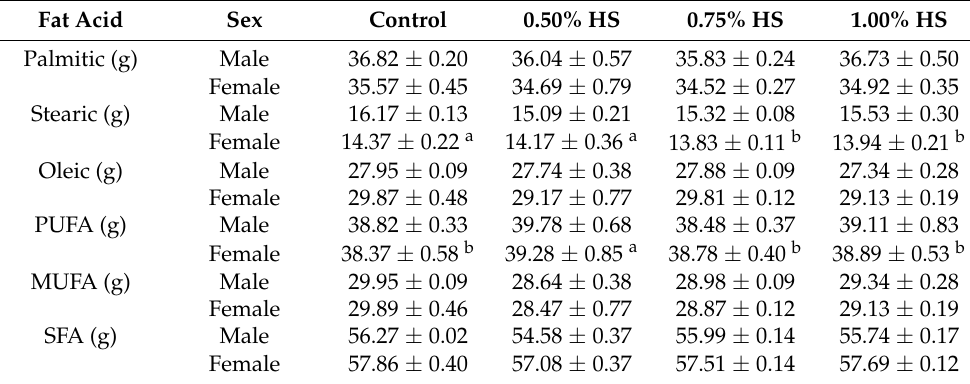
Table 6. The effect of HSs on the content of fat acids in breast samples.